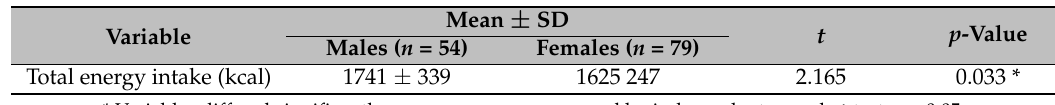
Table 5. Energy intake of males and females ( n = 133).